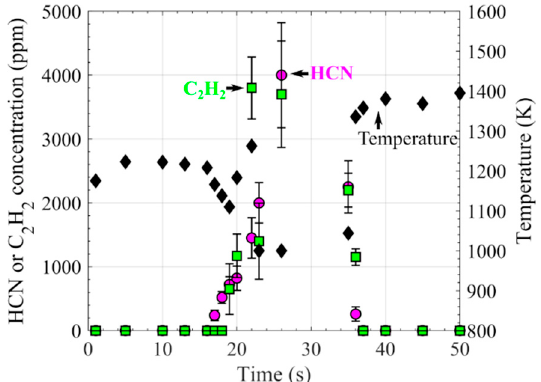
Figure 8. Variation in the HCN and C 2 H 2 concentrations in the plume 5 mm above burning nylon 66 strips in the hot flue gas at 1790 K provided by flame F7, and the local temperature obtained based on Equation (2). (HCN: magenta circle, C 2 H 2 : green square, temperature: black diamond).